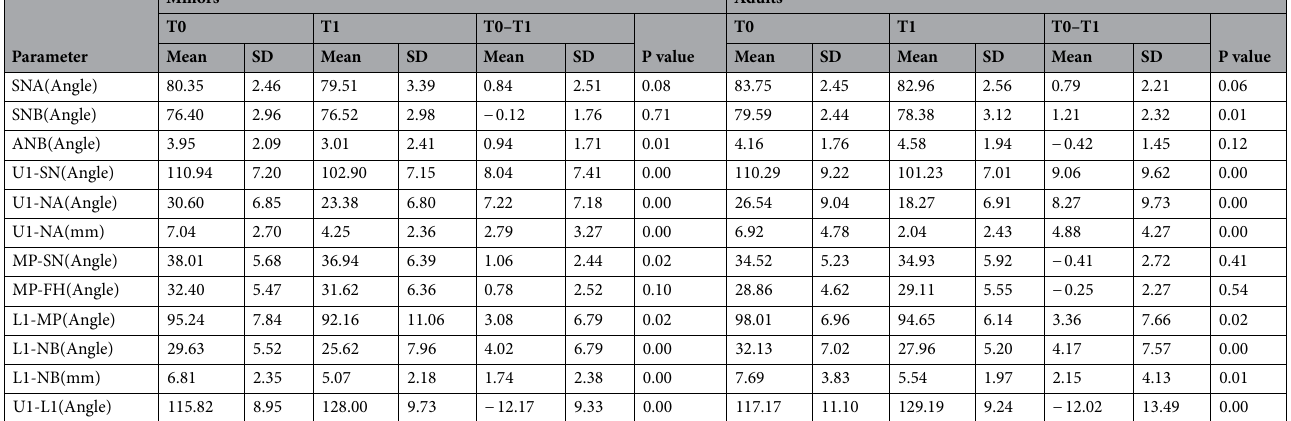
Table 1. The cephalometric data of minors and adults before and after the orthodontic treatment. SD standard deviation, T paired t test, W Wilcoxon test.